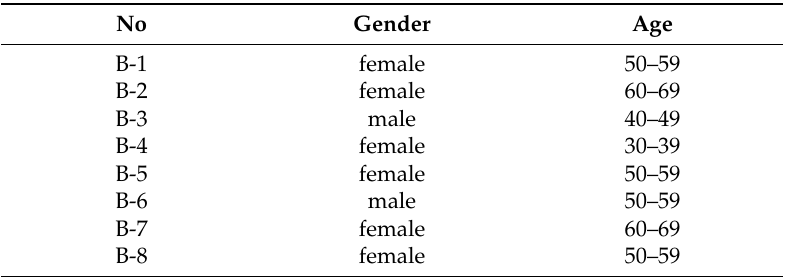
Table 2. Demographics of responding domestic horse